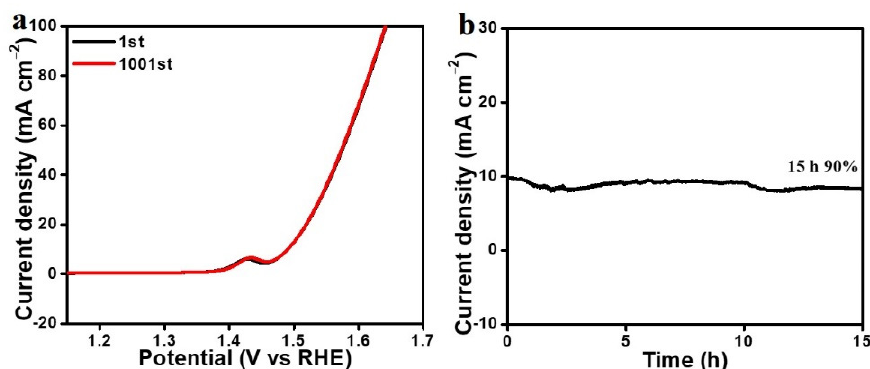
Figure 4. ( a ) The 1st and 1001st CV curves of FeNi 3 /C; ( b ) chronoamperometry test of FeNi 3 /C at the potential of 1.48 V.